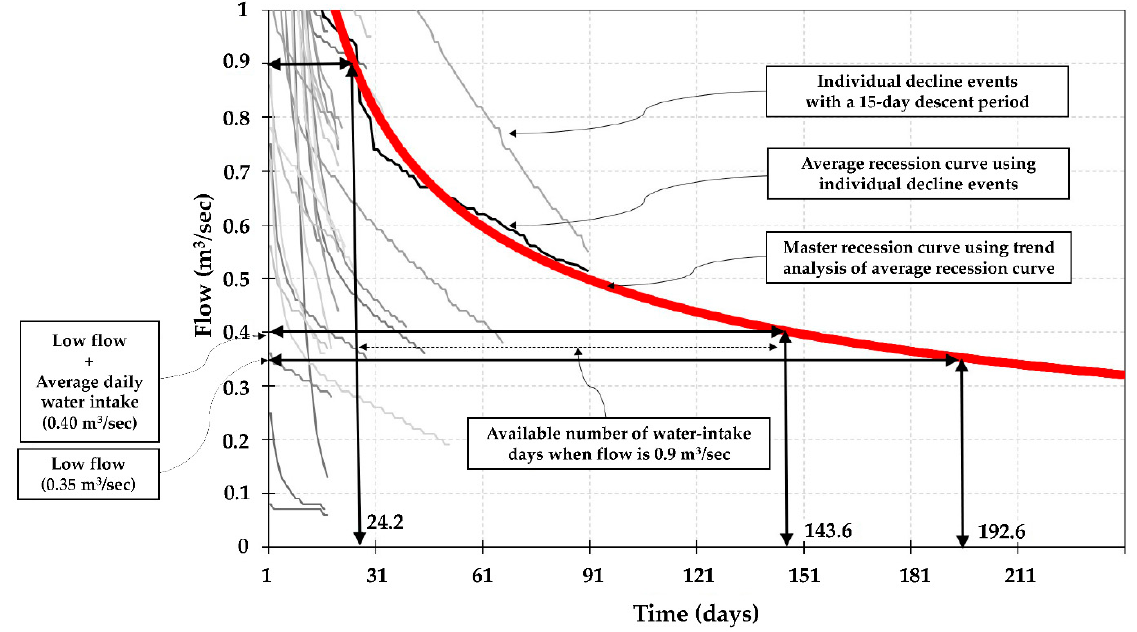
Figure 3. Conceptual scheme of the available number of water intake days using flow recession curve.